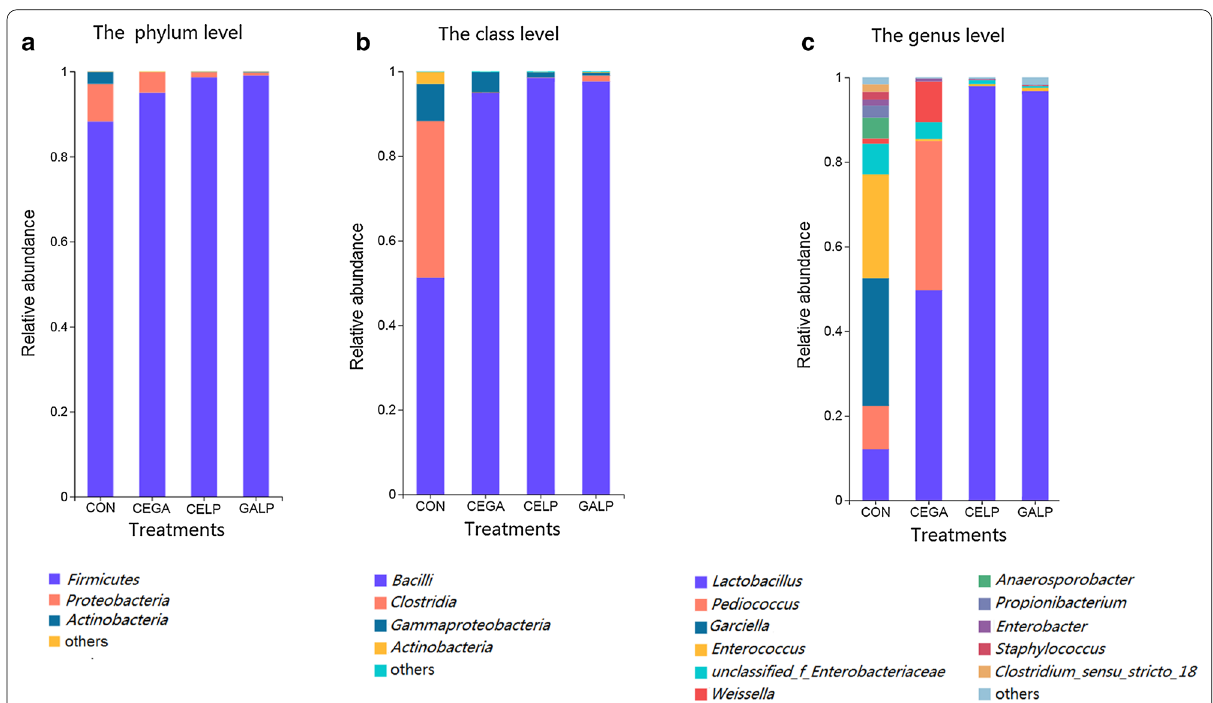
Fig. 2 Bacterial composition of alfalfa silage with different treatments (Control, CEGA, CELP, and GALP) at the phylum ( a ), class ( b ) and genus levels ( c ). Phyla, classes and genera with less than 1% overall relative abundance were summed and presented as “others”. CON untreated silage, CEGA cellulase plus ɑ -galactosidase, CELP cellulase plus L. plantarum , GALP ɑ -galactosidase plus L. plantarum